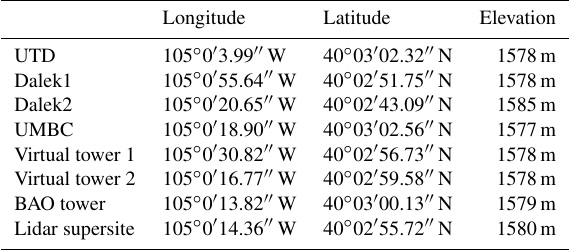
Table 1. GPS locations of the four scanning Doppler wind lidars, two virtual towers generated with the triple RHI scans, wind lidar profilers (lidar supersite) and BAO tower.